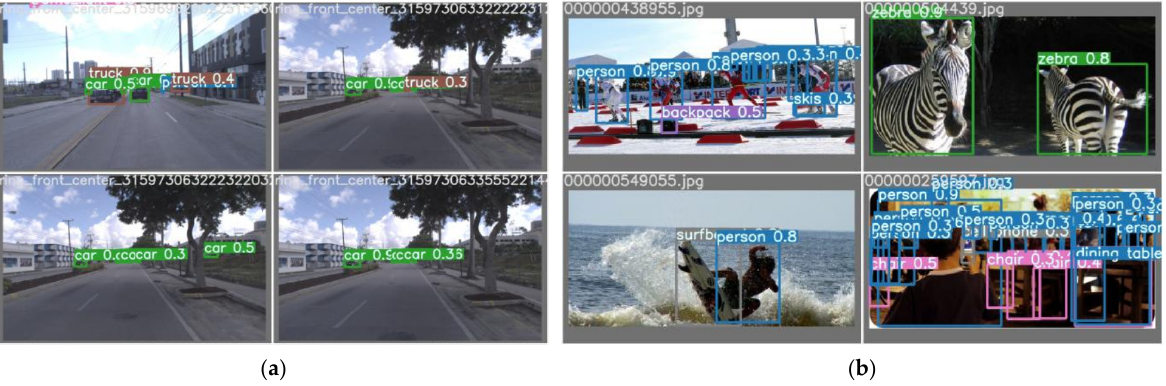
Figure 10. Test results of the proposed NextDet’s sparse and dense object detection along with confidence scores on the validation set of images. Image ( a ) provides object detection result on the Argoverse-HD dataset, and image ( b ) provides object detection result on the COCO dataset.